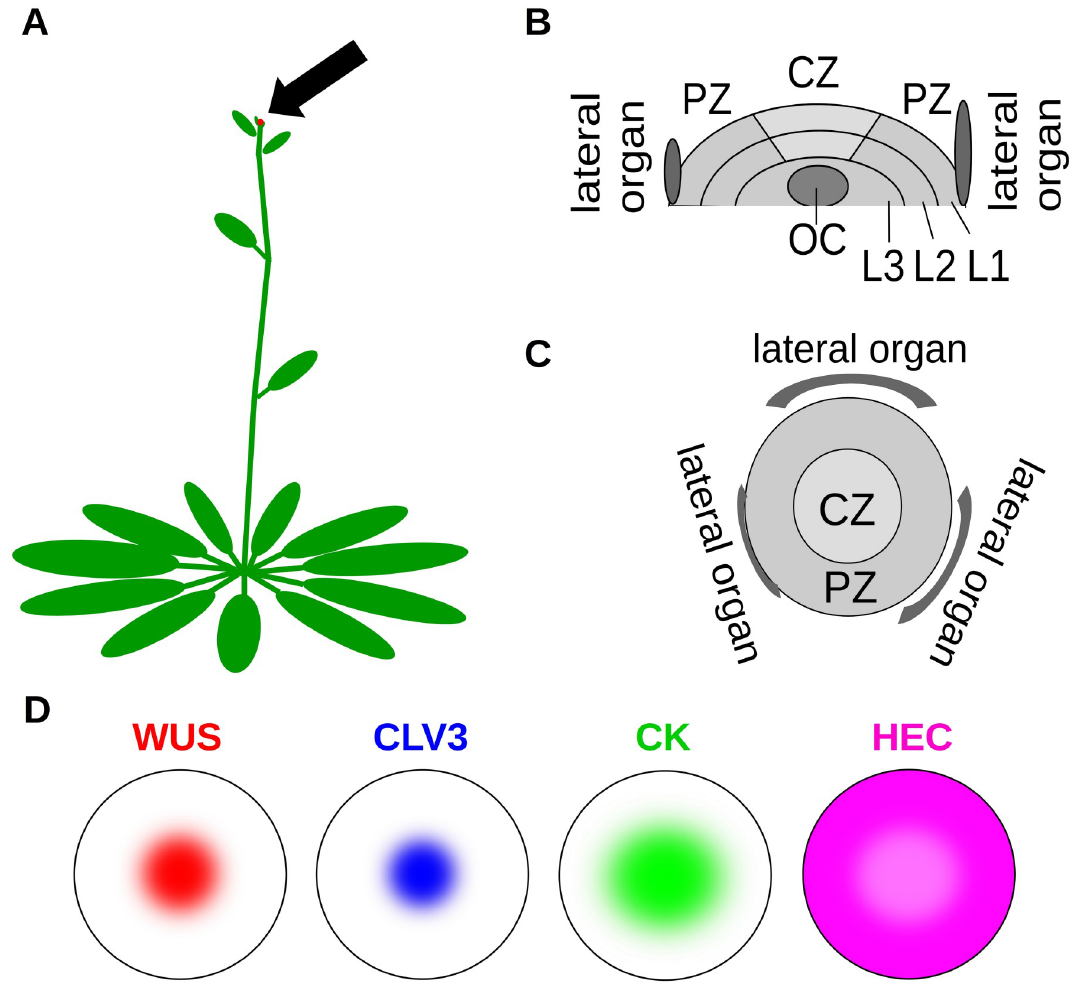
Fig 1. SAM (shoot apical meristem) location and morphology. (A) The SAM is located at the apex of the plant shoot (arrow). (B) Longitudinal section of the SAM. The SAM consists of three layers: L1 (epidermal cell layer), L2 (subepidermal cell layer) and L3 (corpus cell layer). (C) SAM view from the top. CZ: central zone, location of stem cells, PZ: peripheral zone, location of transit amplifying cells. OC: organizing center, location of cells producing signals that induce stem cell fate. L1, L2, L3: layers of the SAM. (D) Spatial expression patterns of key